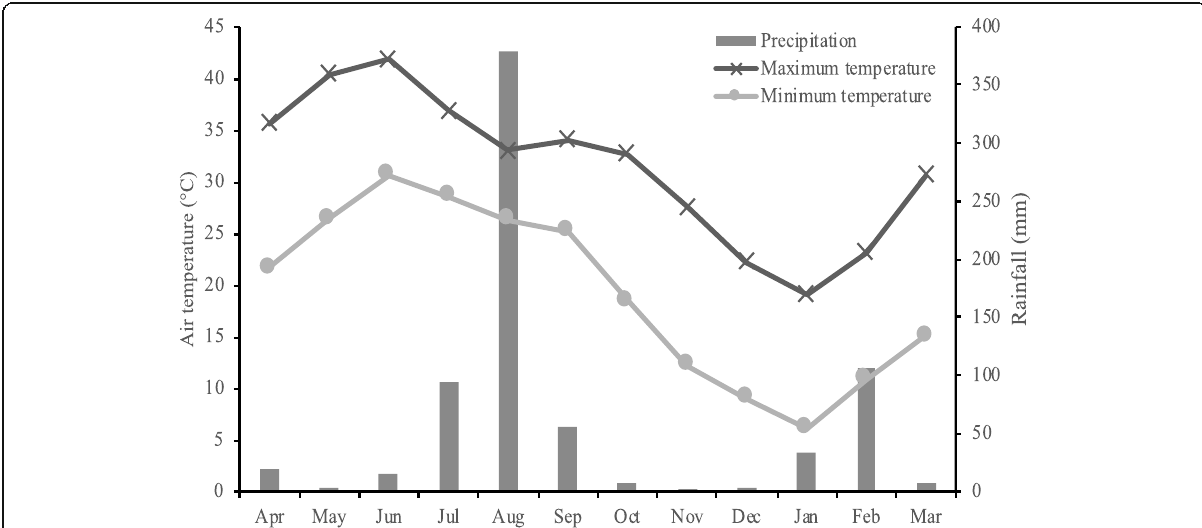
Fig. 2 Monthly average maximum and minimum air temperature (°C) and total precipitation (mm) for the period 2012 – 2013 in study area Delhi,